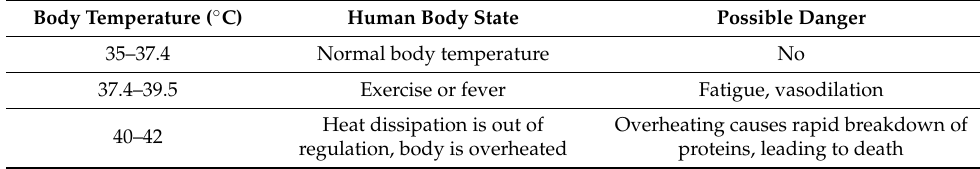
Table 3. Effect of body temperature on the human body [3].